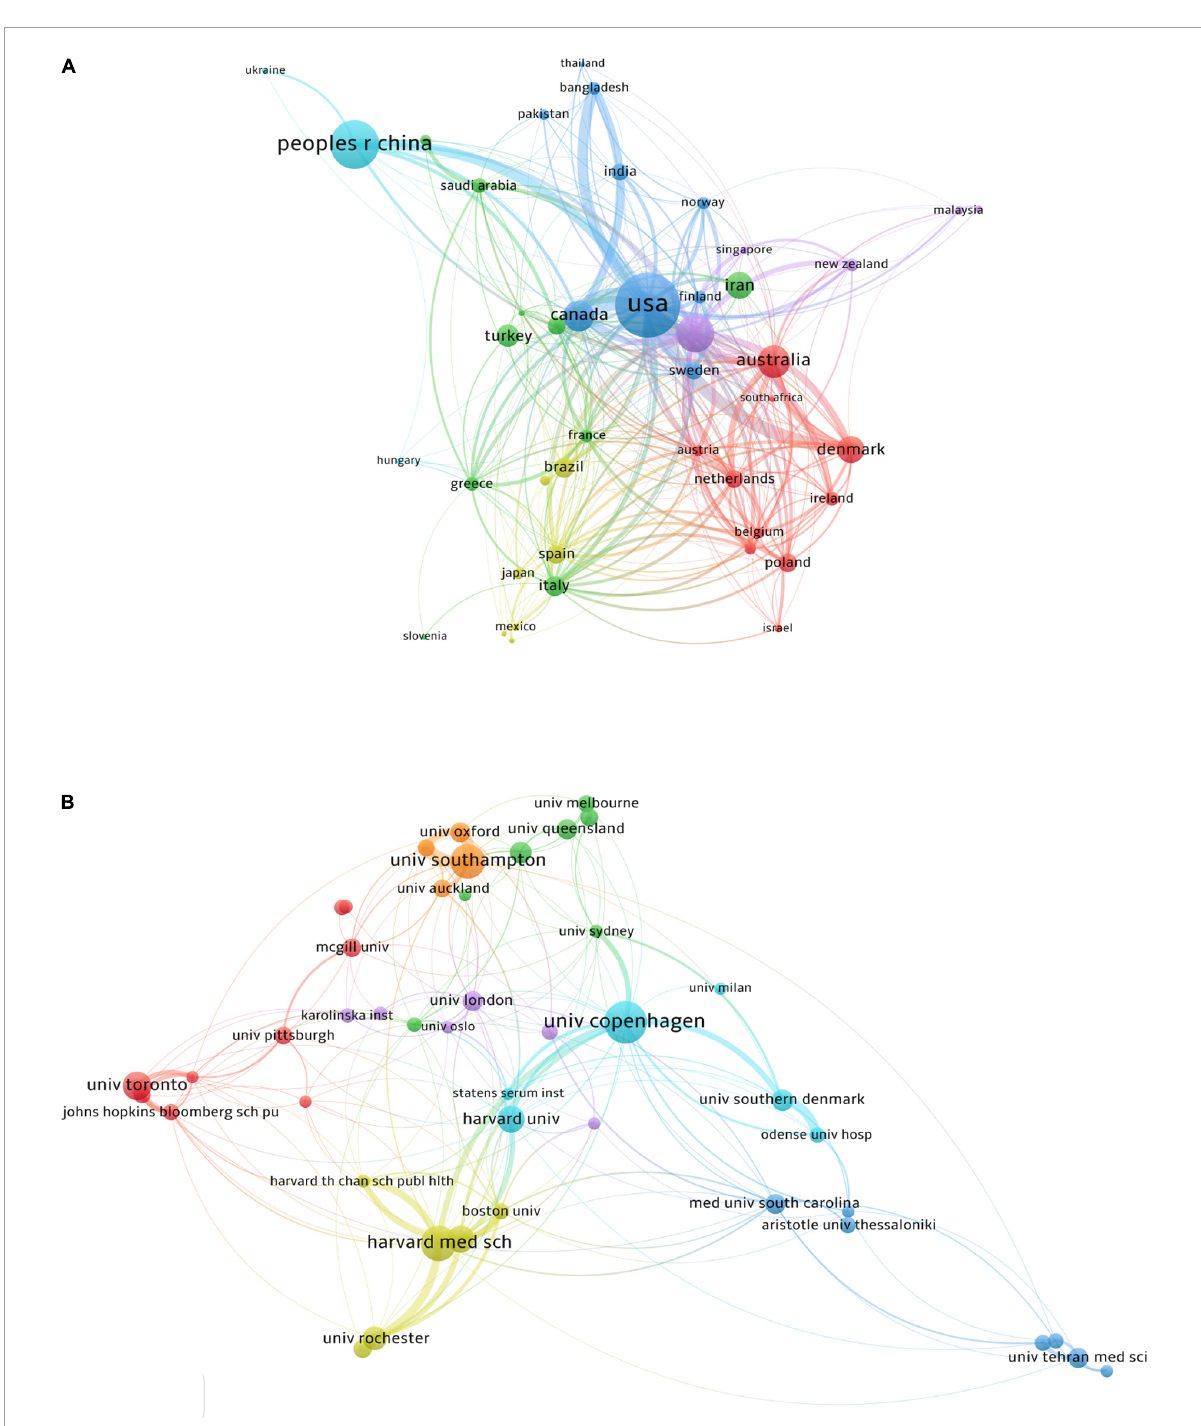
FIGURE3 Co-authorship analysis of countries and institutions. (A) Network map of co-authorship between countries with more than five publications. (B) Network map of co-authorship between institutions with more than 15 publications.